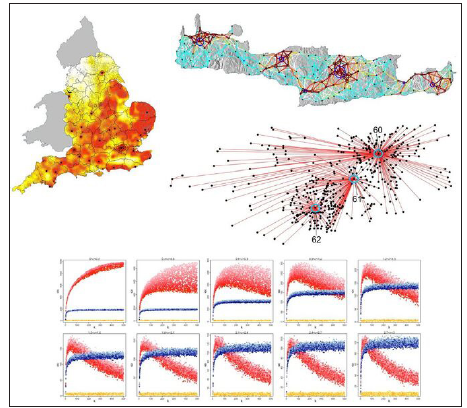
Figure 2: Images demonstrating computa- tional modelling and spatial analytical tech- niques (Images UCL Institute of